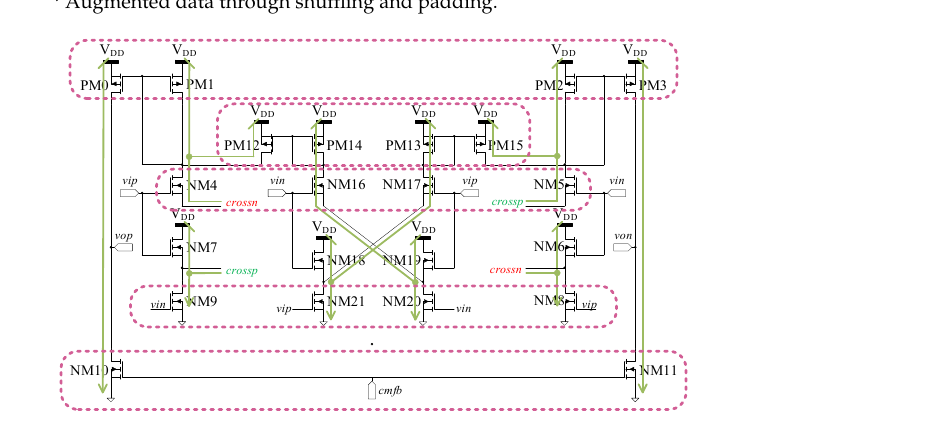
Figure 5. Schematic of the VCOTA [25]. Current-paths highlighted in green and row regularity constraints highlighted in pink. Table 3. List of topological constraints specified for the VCOTA.